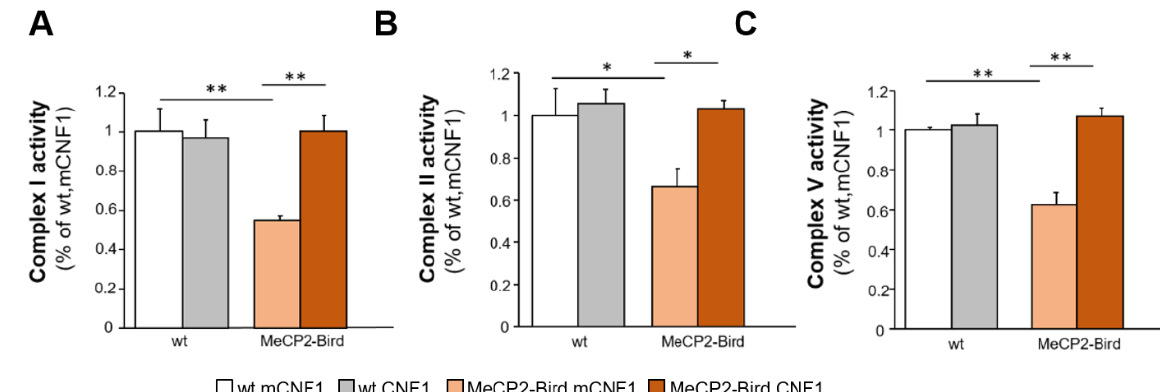
Figure 3. Treatment with CNF1 normalises the activity of mitochondrial respiratory chain complexes in symptomatic MeCP2-Bird mouse cortices. The activity of the mitochondrial respiratory chain (MRC) complexes I ( A ), II ( B ) and V ( C ) were measured spectrophotometrically in mitochondrial membrane-enriched fractions of experimental animals’ brain cortices. Symptomatic MeCP2-Bird female mice treated with an inactive form of the bacterial toxin (mCNF1) displayed reduced MRC complexes activity relative to wild type controls (wt, mCNF1). CNF1 restored wt-like levels of activity in treated MeCP2-Bird mice. Complex activities are expressed as percentage of the activity measured in wt, mCNF1 (set equal to one). Mice for each condition were as follows: wt, mCNF1: 3; wt, CNF1: 4; MeCP2-Bird, mCNF1: 4; MeCP2-Bird, CNF1: 4. Data are mean ± SEM obtained from three independent experiments. Statistical significance was assessed using two-way ANOVA and Tukey’s post hoc tests. *: p < 0.05; **: p <